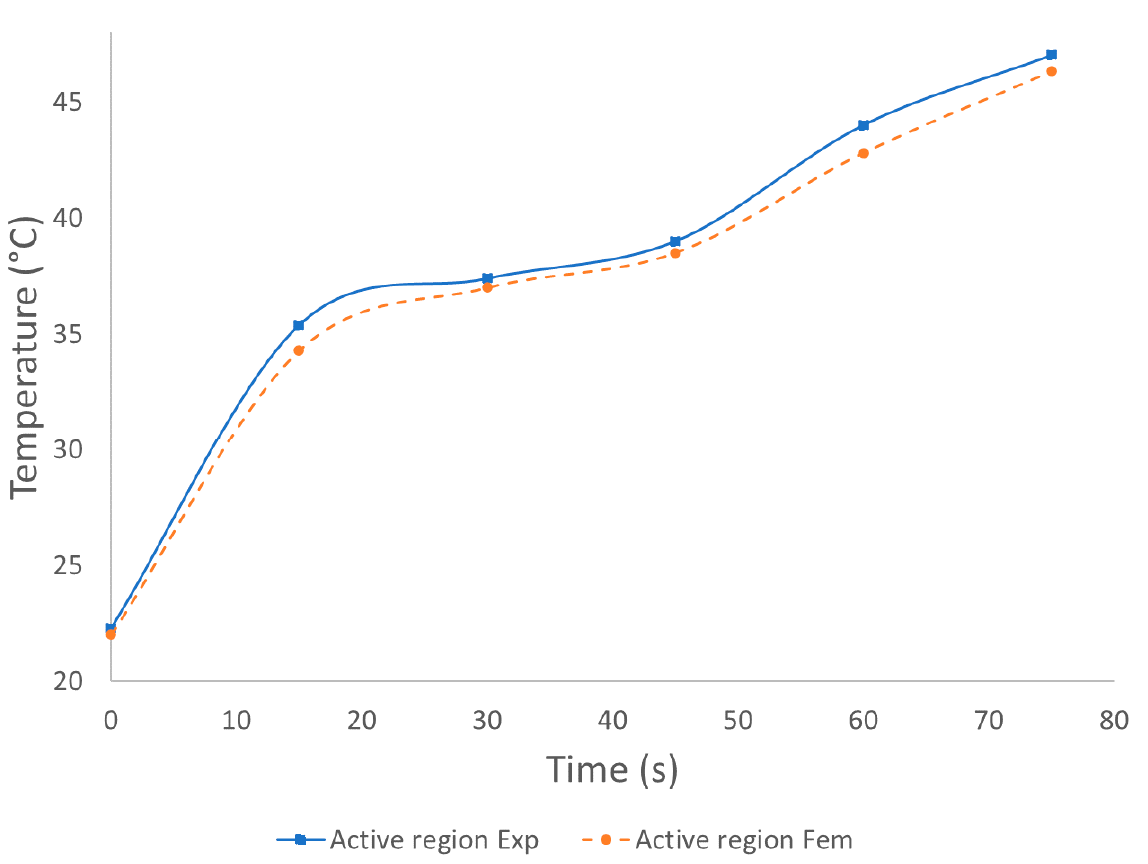
Figure 4. Heat generation process on braking. At the same time, the event of heat generation in the functional or active area can be seen in Figure 5. The area produces a higher temperature than the heat generated in Figure 4. The data taken is the active area on the disc brake and coil section. These results were obtained through a simulation process compared with the experiment. In this case, the coil generates heat up to 77 ◦ C for the experimental data, while the simulation data shows no different results, namely 75 ◦ C. The heat that arises in the disc brake comes from the coil. It causes the disc brake in the active area to have a higher temperature than the side area. The temperature generated by the active disc brake area reached 57 ◦ C during the experiment and 52 ◦ C using